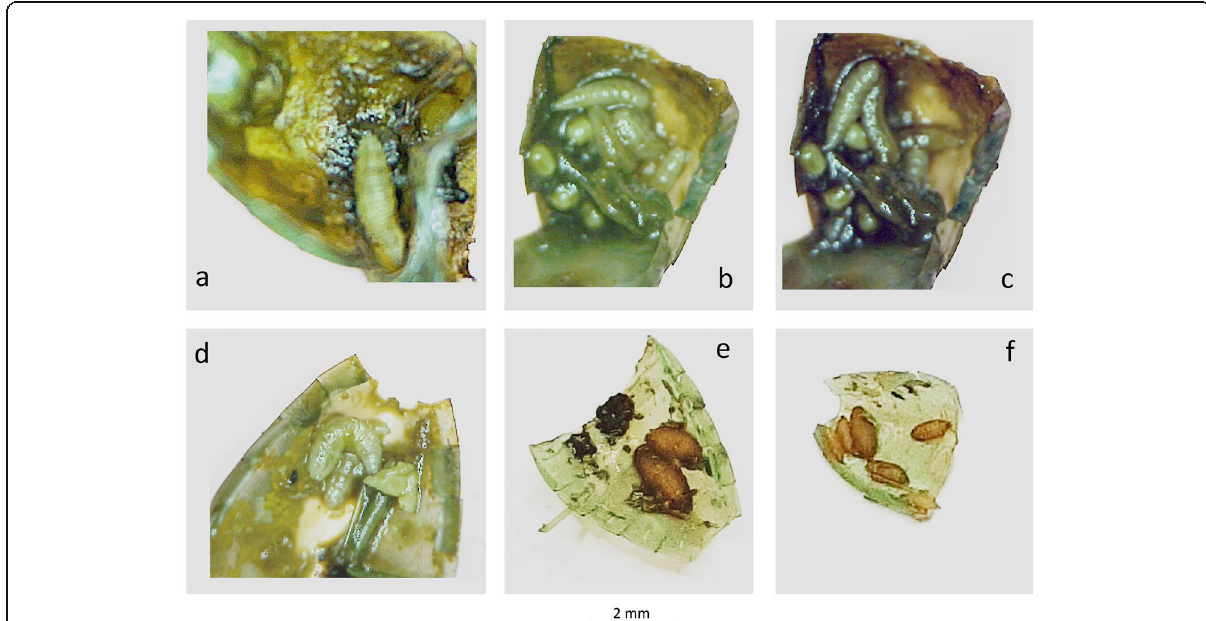
Fig. 4 a – d Third larval instar of Megaselia scalaris inside a dissected abdomen of Nezara viridula (L.). e , f Pupae of Megaselia scalaris inside a dissected abdomen of Nezara viridula